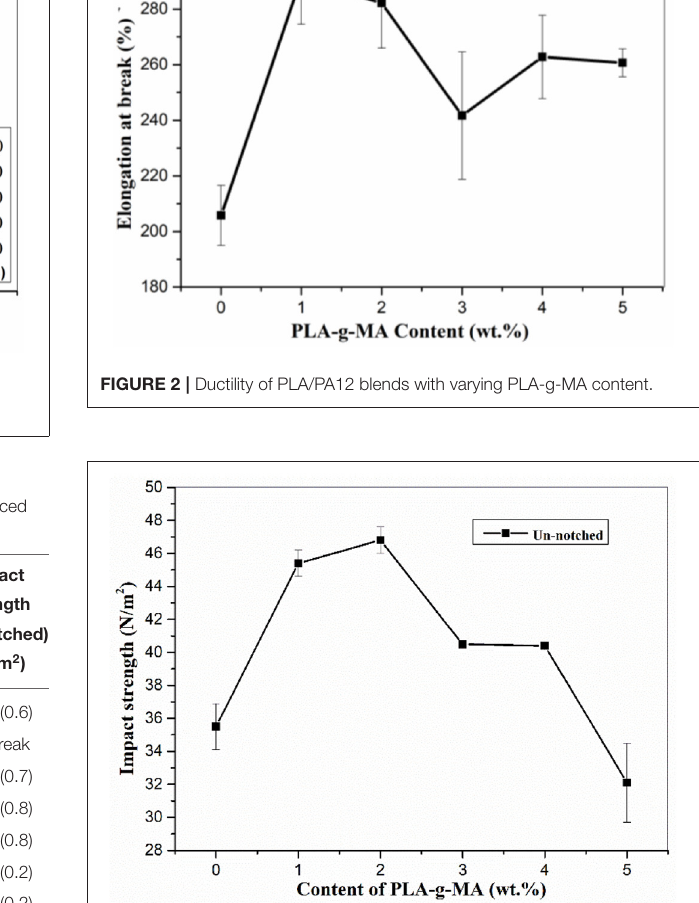
FIGURE 3 | Impact strength of the PLA/PA12 blends with varying concentration of